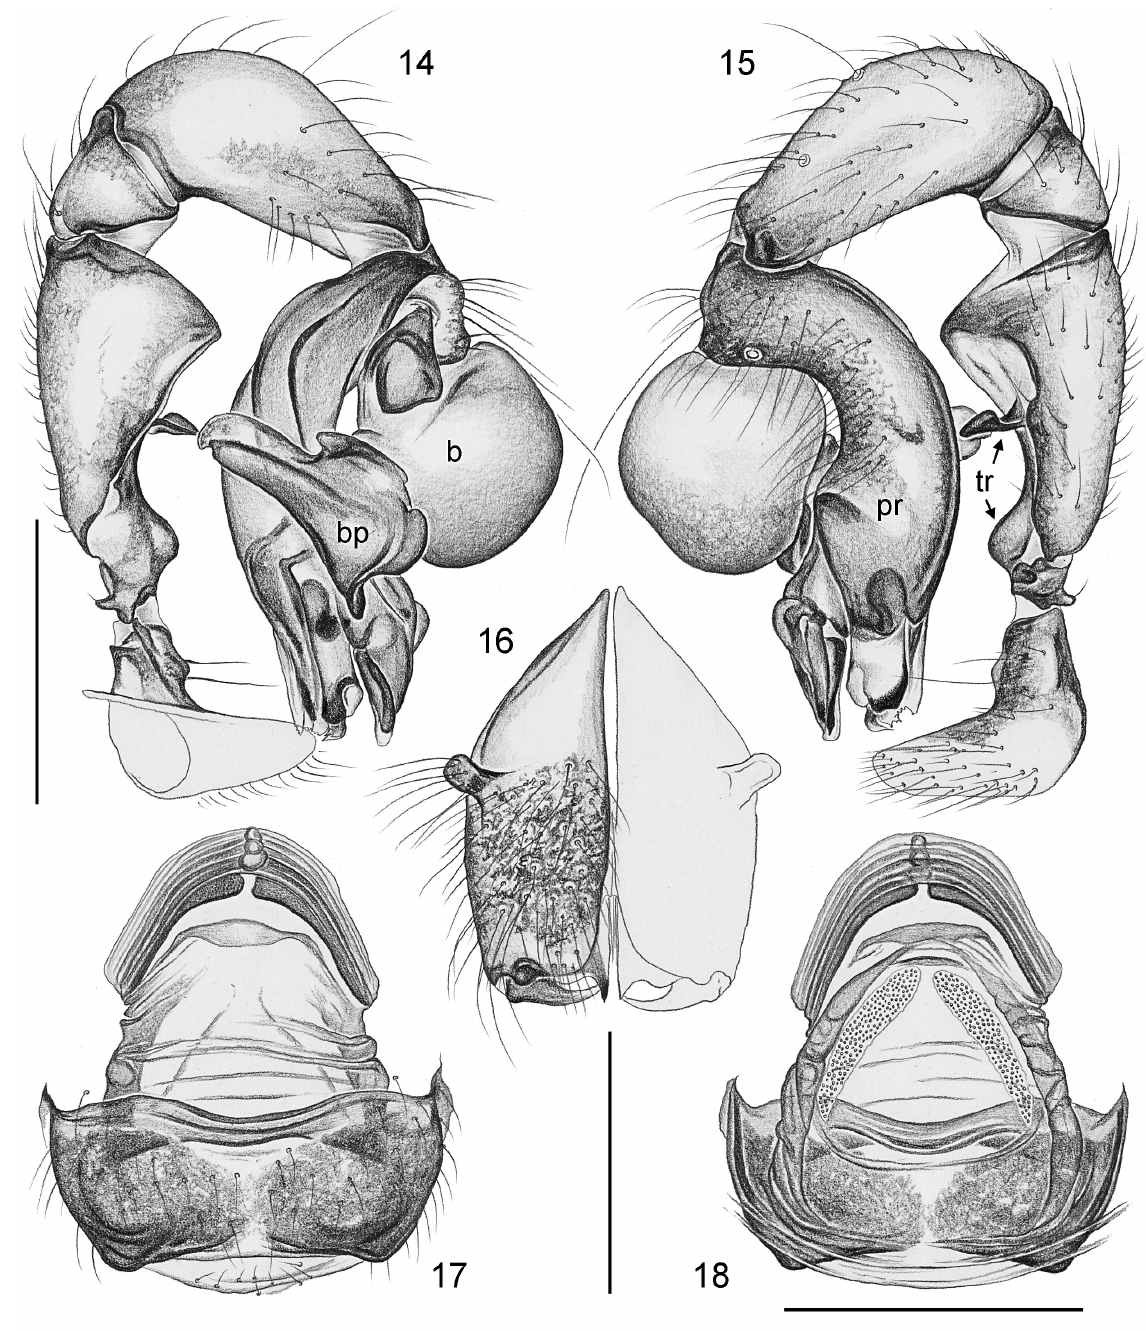
Figs 14–18. Savarna kaeo sp. nov. 14–15 . Left male palp, prolateral and retrolateral views (b = genital bulb; bp = bulbal process; pr = procursus; tr = trochanter). 16 . Male chelicerae, frontal view. 17–18 . Cleared female genitalia, ventral and dorsal views. Scale bars: 16 = 0.3 mm; 14–15, 17–18 =